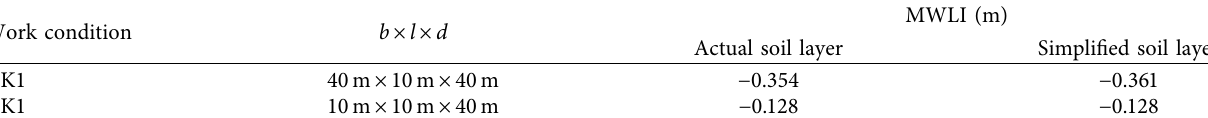
Table 3: Comparison of the MWLIs obtained by simulation considering the actual soil layer and the simplifed soil layer. Work condition